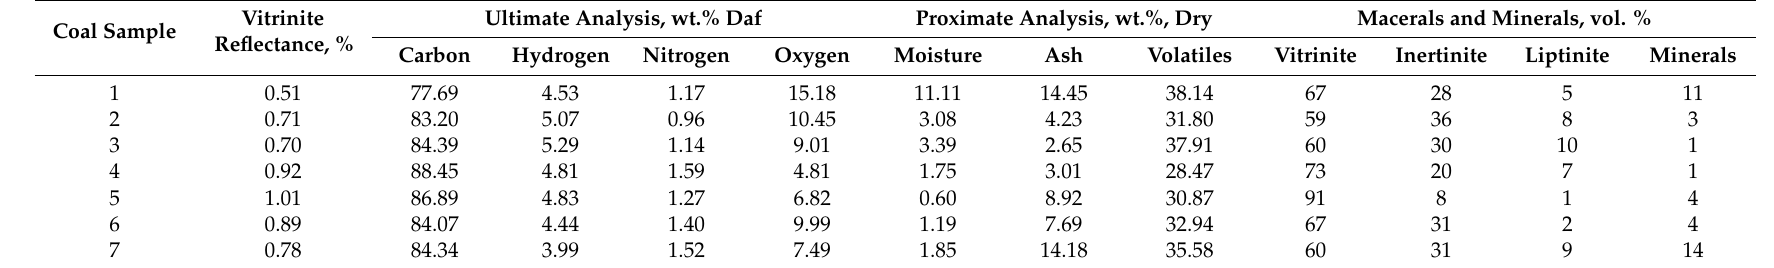
Table 1. Characteristics of coal samples.